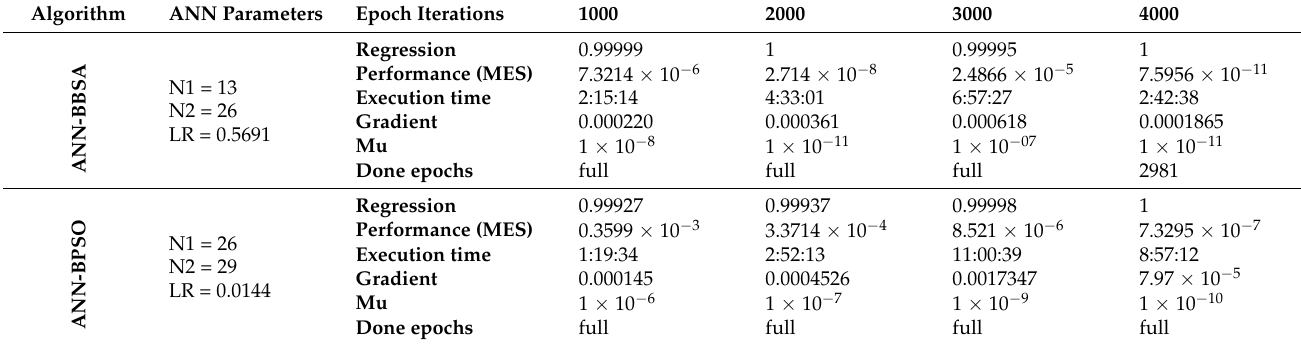
Table 6. Representing a comparison between both ANN algorithms’ training with changes in epochs. Algorithm ANN